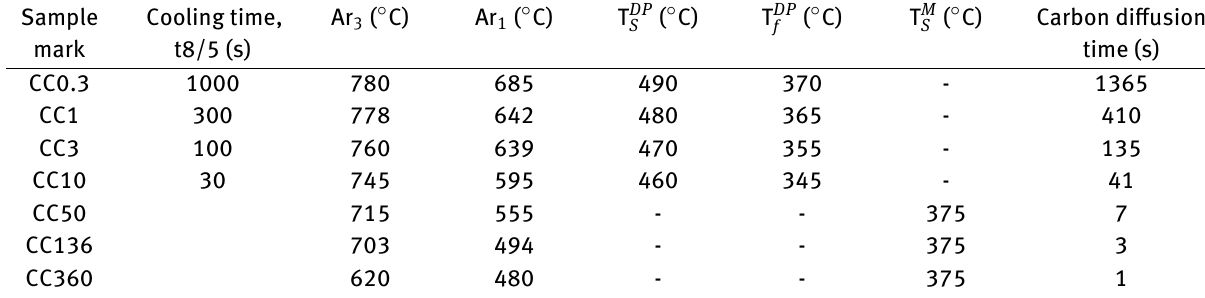
Table 4: list of various phase transformation start temperature in association with the carbon partitioning time for enrichment into the remaining prior austenite in different weld simulated samples; the polygonal ferrite start temperature ( Ar 3 ), the polygonal ferrite